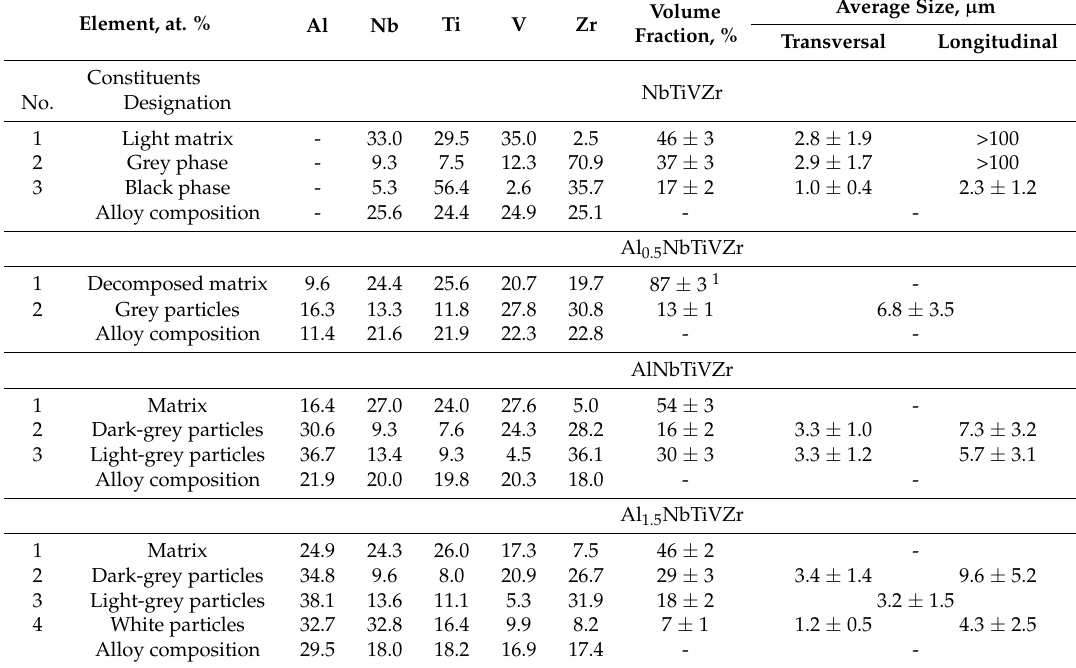
Table 3. Chemical compositions, volume fractions and dimensions of the constituents of the Al x NbTiVZr ( x = 0; 0.5; 1; 1.5) alloys after annealing at 800 ◦ C for 100 h. Typical regions used for analysis are shown in Figure